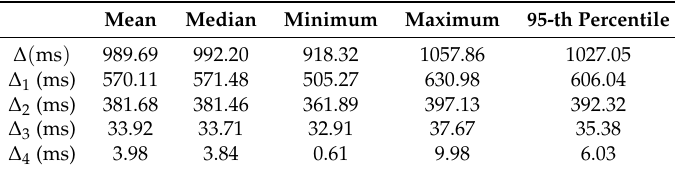
Table 3. Device/UE reassignment time and its components (averaging 100 independent